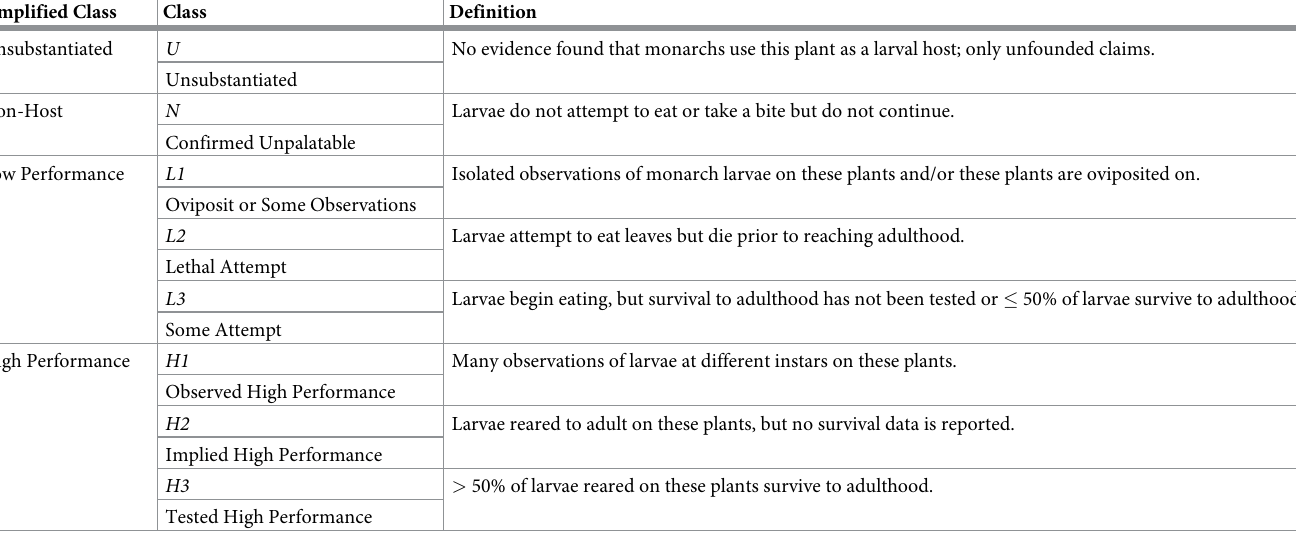
Table 1. Plant host classes and